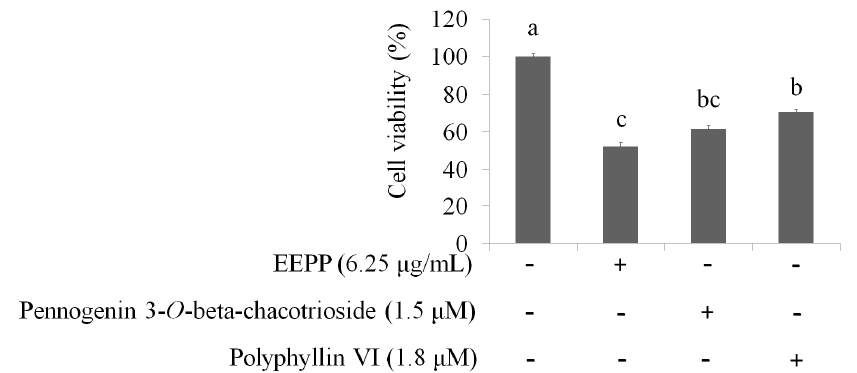
Figure 7. The suppression of DLD-1 colorectal carcinoma cells treated with EEPP (6.25 µ g / mL), pennogenin 3- O -beta-chacotrioside (1.8 µ M), or polyphyllin VI (1.4 µ M) for 24 h. The concentrations of pennogenin 3- O -beta-chacotrioside and polyphyllin VI were calculated according to EEPP. Data are shown as means ± SD ( n = 3). The significant di ff erences are denoted by di ff erent letters ( p < 0.05).